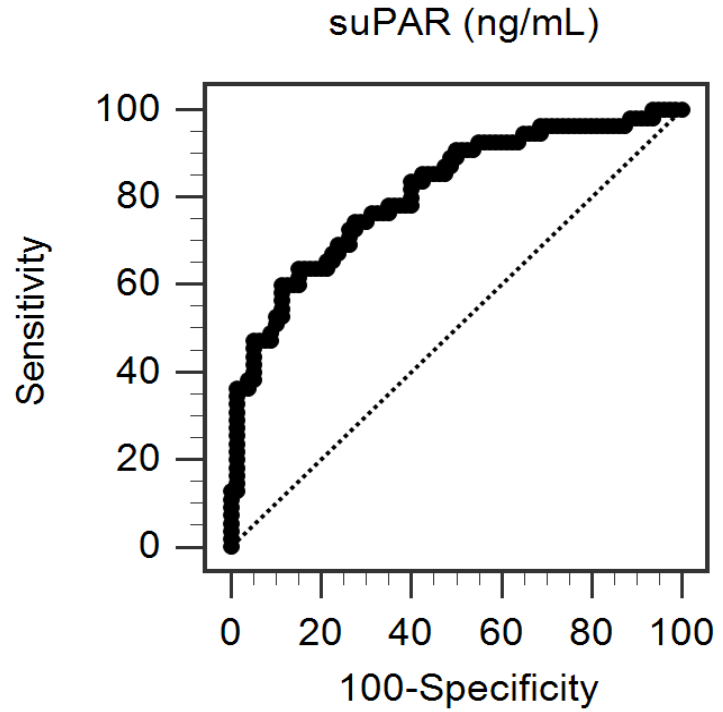
Figure 2. ROC curve for arterial stiffness prediction, determined by soluble urokinase-type plasmino- gen activator receptor (suPAR) level.